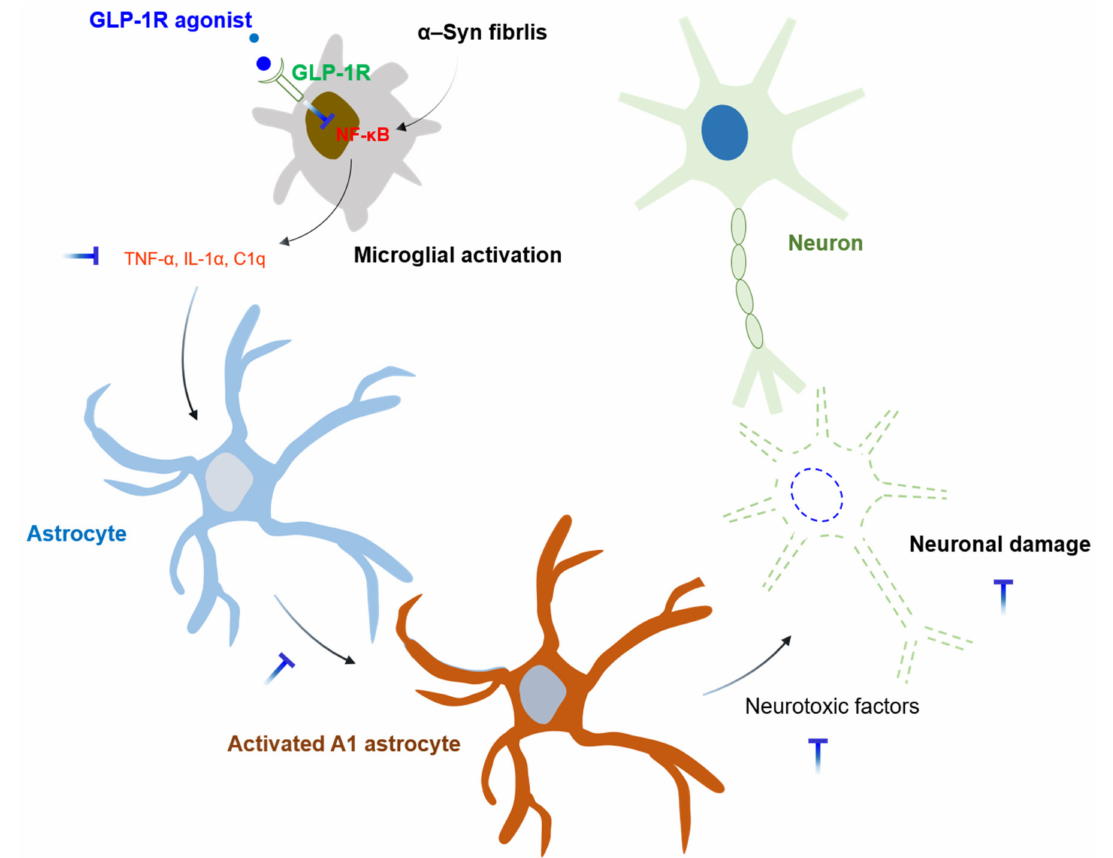
Figure 2. The role of microglial GLP-1R in AD and PD. The binding of GLP-1 to GLP-1R on microglia promotes the expression of pro-inflammatory cytokines and neurotoxic molecules, leading to A1 astrocyte activation and neuronal damage. GLP-1 agonists exert neuroprotective effects in AD and PD by regulating NF- κ B activation and A1 astrocyte activation and suppressing neuronal damage. Therefore, GLP-1/GLP-1R signaling is highlighted in novel therapeutic strategies in AD and